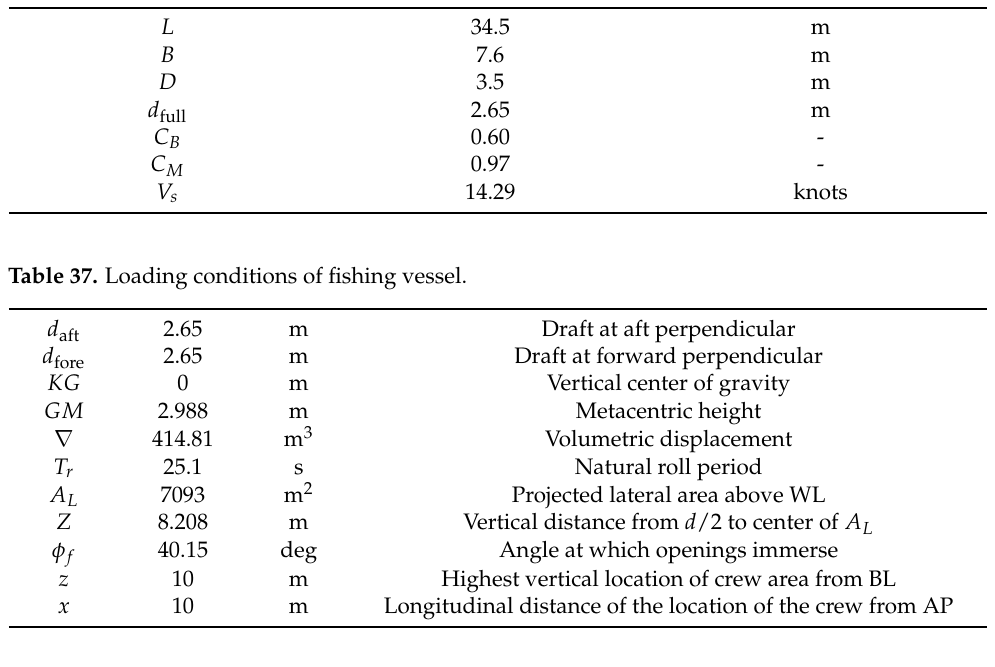
Figure 24. Isometric view of fishing vessel geometry in section-based GF format. Blue lines mark the deck edge. See Section 6 for a link to download this geometry file. Table 36. Principal dimensions of fishing vessel.